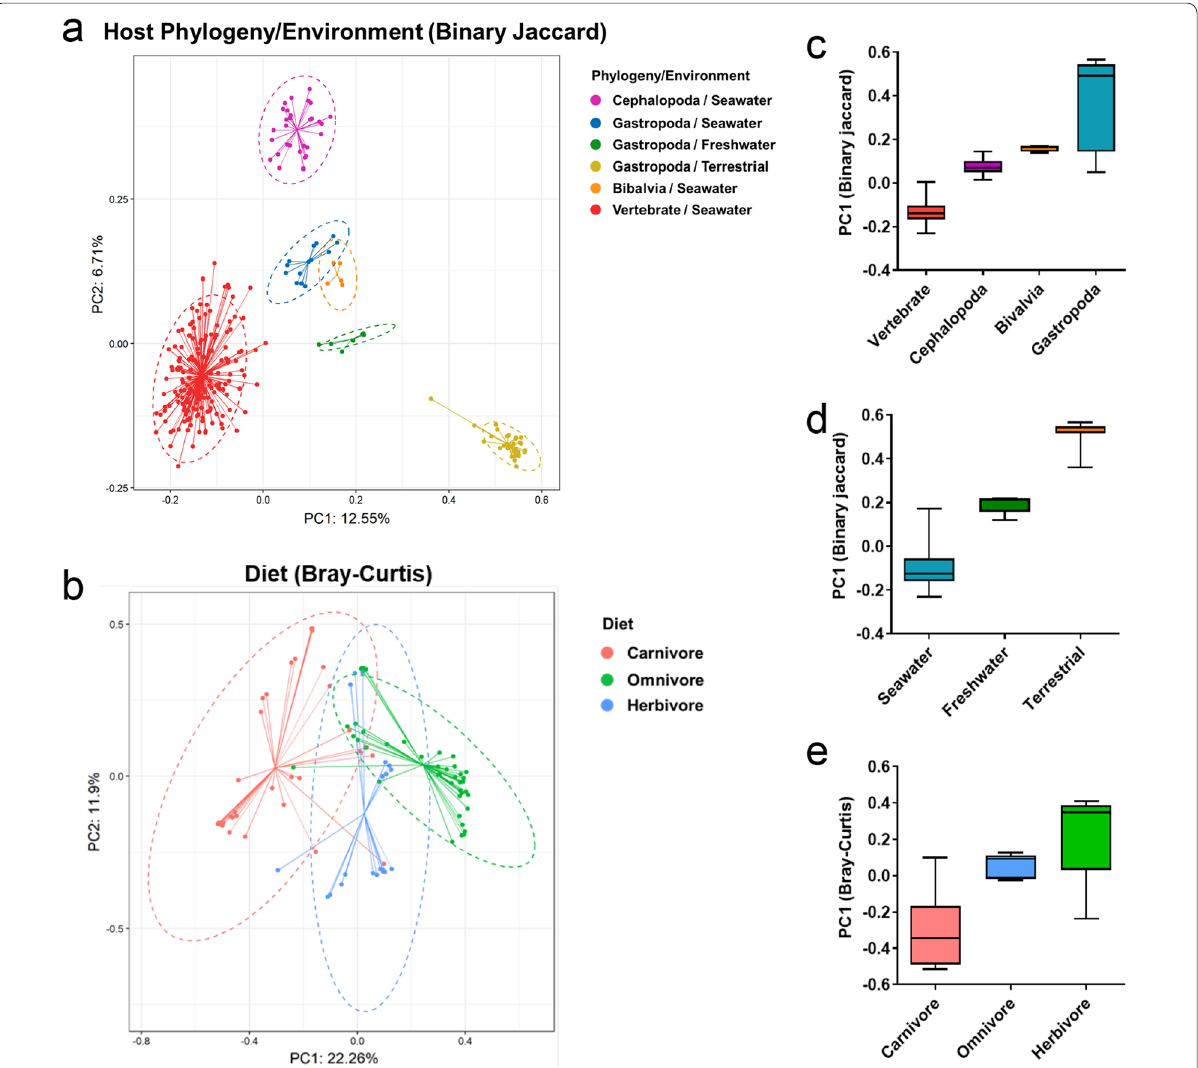
Fig. 6 Ecological characteristics of global mollusk and fish gut microbiomes. a , b PCoA ordination of the microbial community of mollusks and fish with a binary Jaccard and b Bray–Curtis indices. The different colors represent a host phylogeny, habitat, and b diet group. Centroids and ellipses for each group are also shown. c – e Boxplot diagram of the PC1 for each a host phylogeny/habitat and b diet group. The letters above the whisker indicate significant differences ( p < 0.05) among groups (Mann–Whitney U